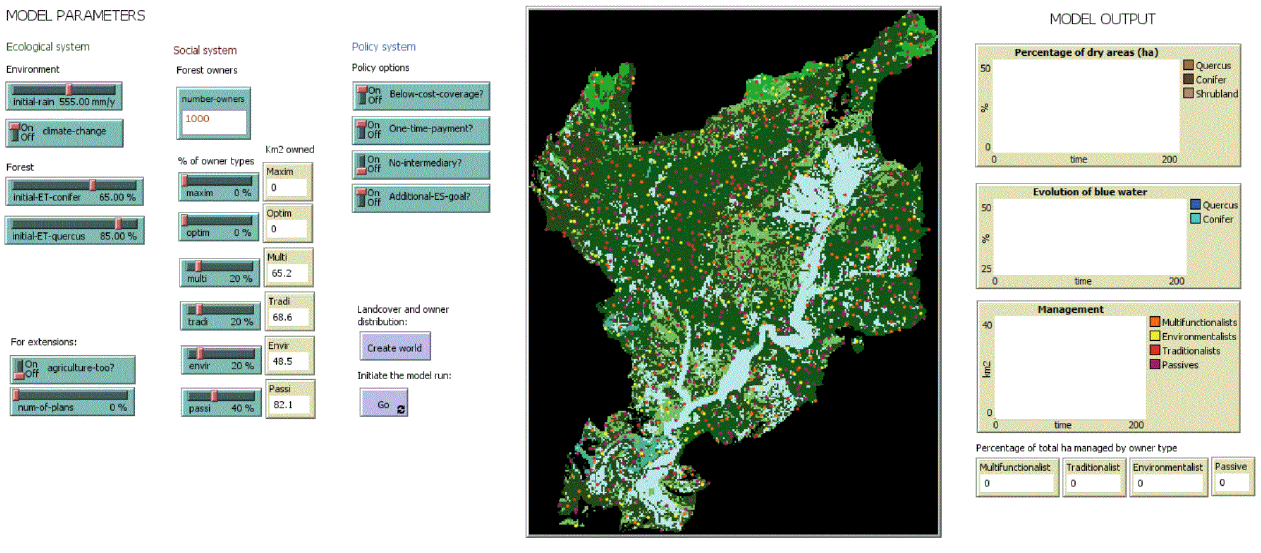
Fig. 3 . Model interface as implemented in Netlogo.